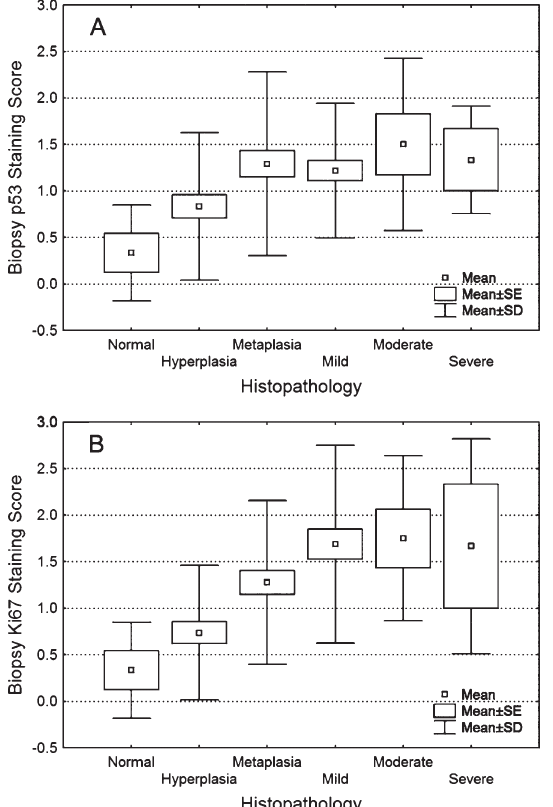
Fig. 4. Box plots comparing p53 (A) and Ki67 (B) staining score to histopathological grade for the 159 biopsy samples from sites that had a biopsy grading of dysplasia or worse at baseline or